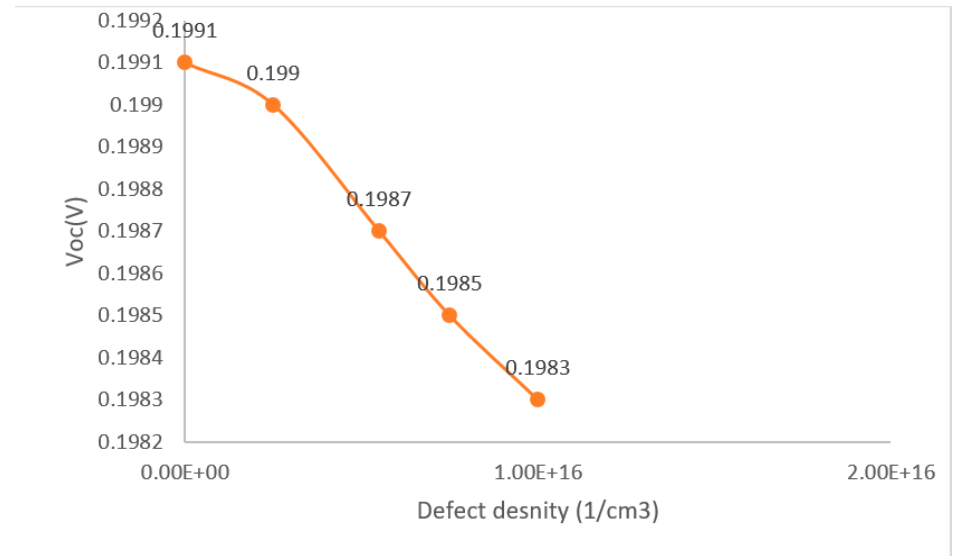
Figure 9. Variation of Voc with defect density.